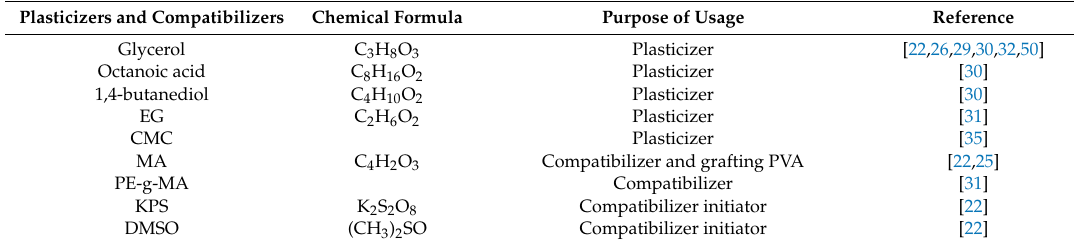
Table 6. Plasticizers and